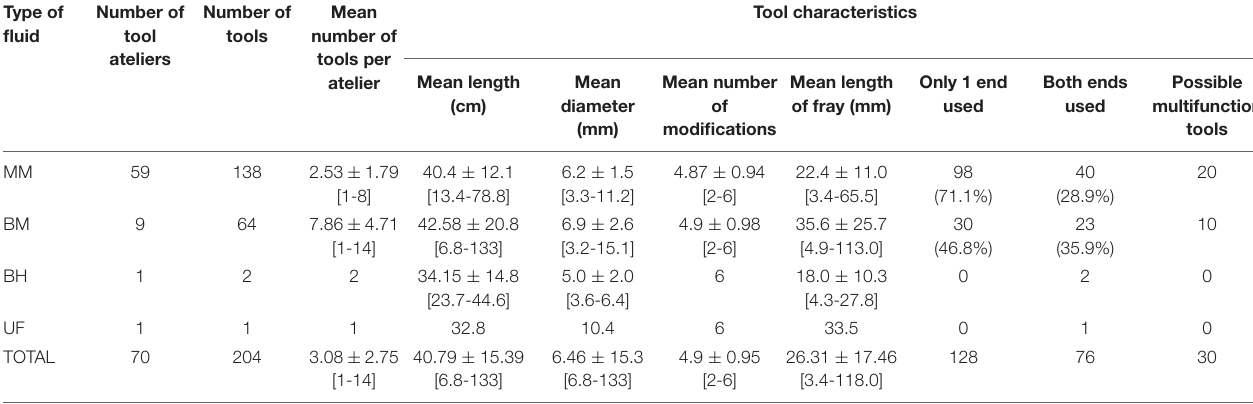
TABLE 1 | Summary of tools and tool characteristics as a function of type of fluid exploited. Type of fluid